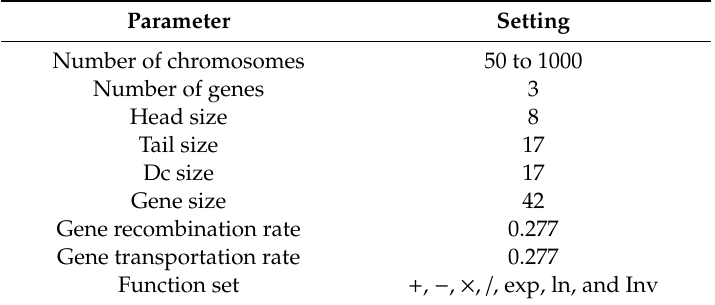
Table 2. Parameters used for implementation of the GEP-based